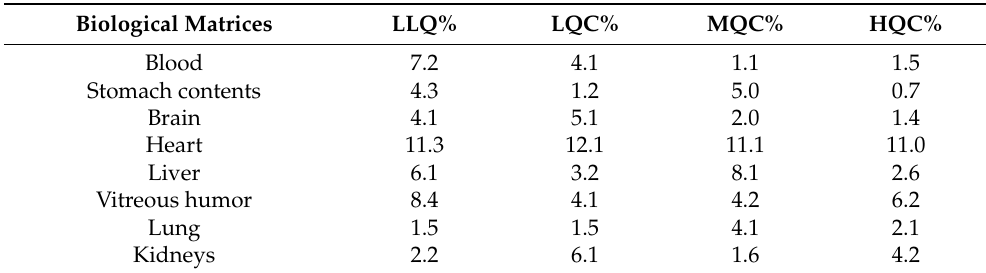
Table 6. Precision in each matrix for carbofuran was evaluated by means of the coefficient of variation (CV%) of the lower limit of quantification (LLQ), low-quality control (LQC), medium-quality control (MQC), and high-quality control (HQC).